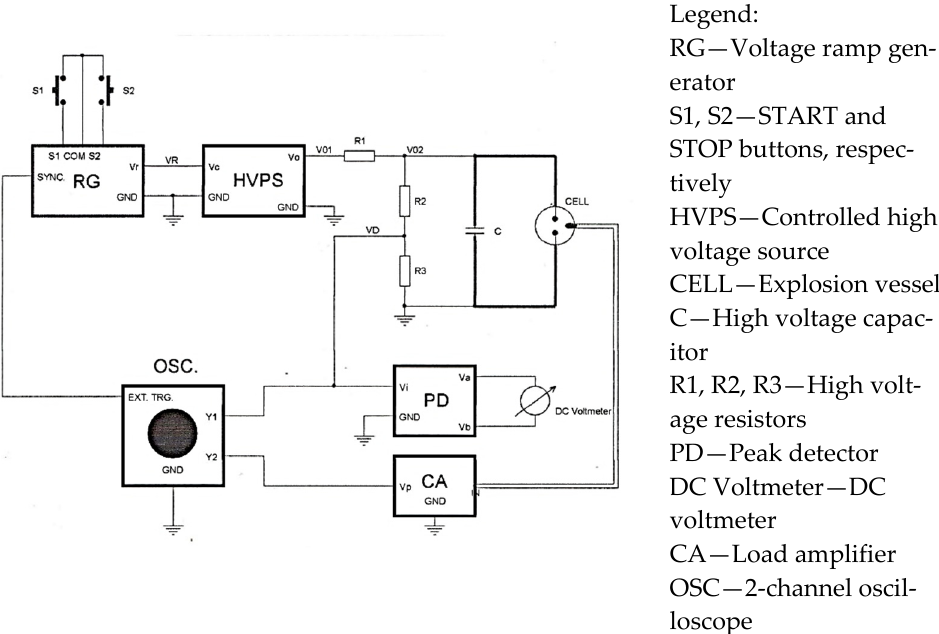
Figure 3. A block diagram for the generation of the capacitive sparks. The maximum rates of pressure rise (d p /d t )max were computed from pressure–time diagrams after smoothing the p(t)data by Savitzky–Golay method, based on the least– squares quartic polynomial fitting across a moving window within the data. The method,